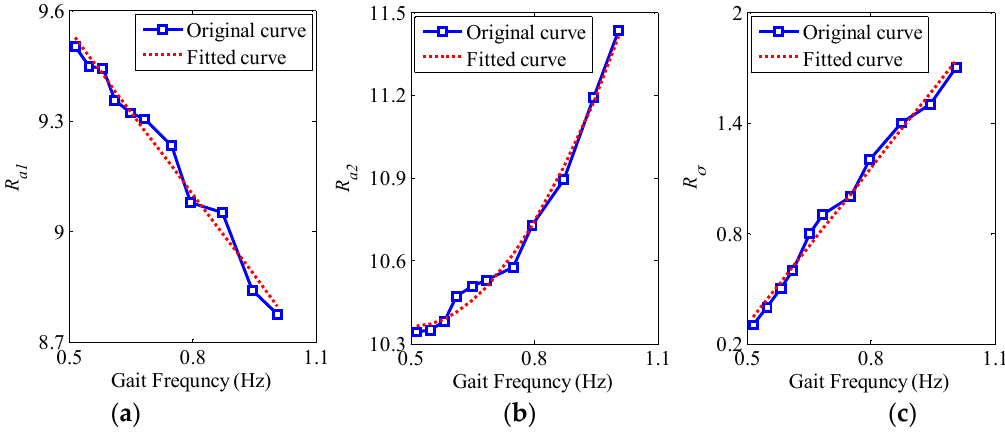
Figure 9. The relationships between the thresholds and the gait frequency. ( a ) The minimum threshold of the acceleration magnitude to the gait frequency; ( b ) The maximum threshold of the acceleration magnitude to the gait frequency; ( c ) The threshold of the acceleration variance to the gait frequency.